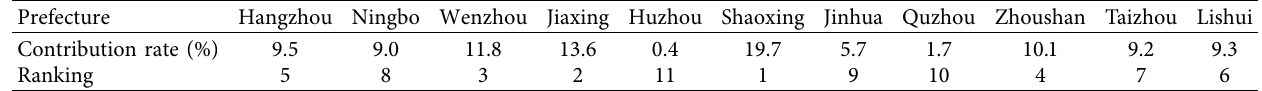
Table 6: Contribution rate and ranking of each preference.